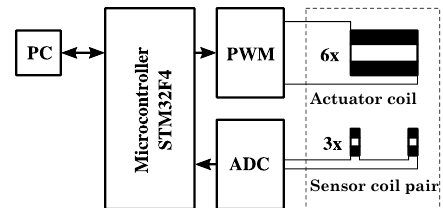
Figure 4. Block diagram of the measurement